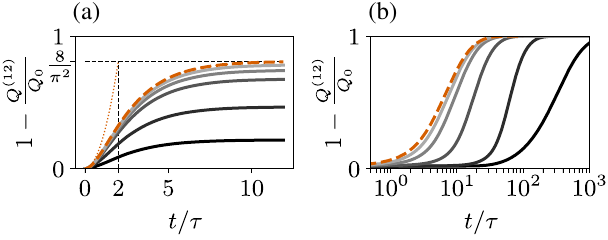
FIG. 6. Discrete chaos versus continuous chaos. (a) Evolution of the decorrelation between replicas in the binary network (19) with T ¼ tanh. Increasing coupling strength from dark to light gray, g ¼ f 0 . 5 ; 1 ; 2 ; 3 ; 5 g . Dark orange curves: limit g → ∞ or Heaviside T (dashed); quadratic solution for nonsaturated growth derived in the Appendix 5 (dotted). (b) Evolution of decorrelation between replicas in the rate network (21) obtained by numerical solution of Eq. (24) (details in the Appendix 6). Color code as in (a) but using parameters g ¼ f 1 . 1 ; 1 . 5 ; 2 . 5 ; 5 . 10 g and initial decorrelation of 2% instead of